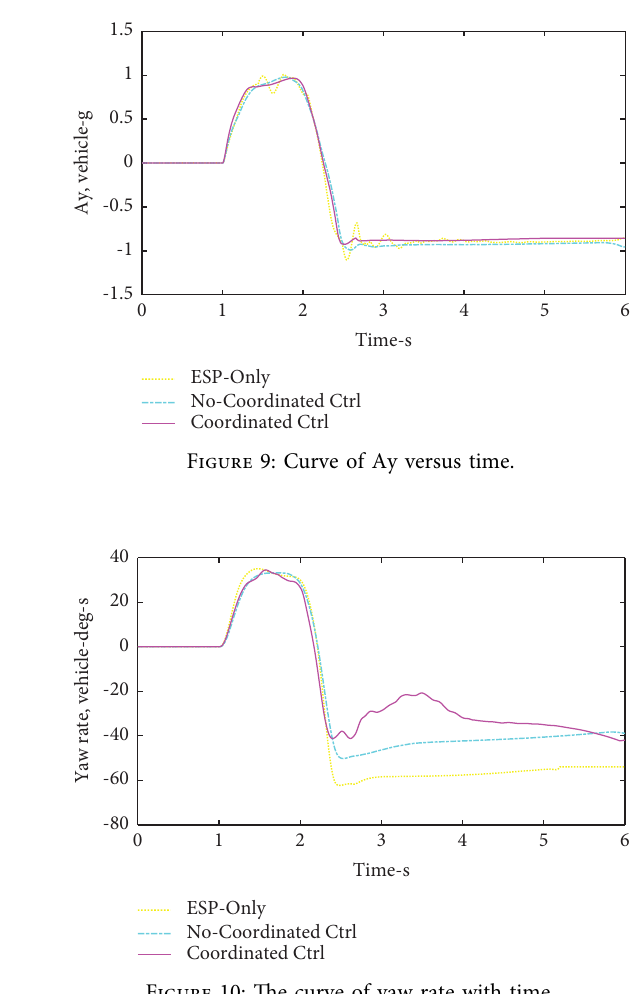
Figure 10: Te curve of yaw rate with